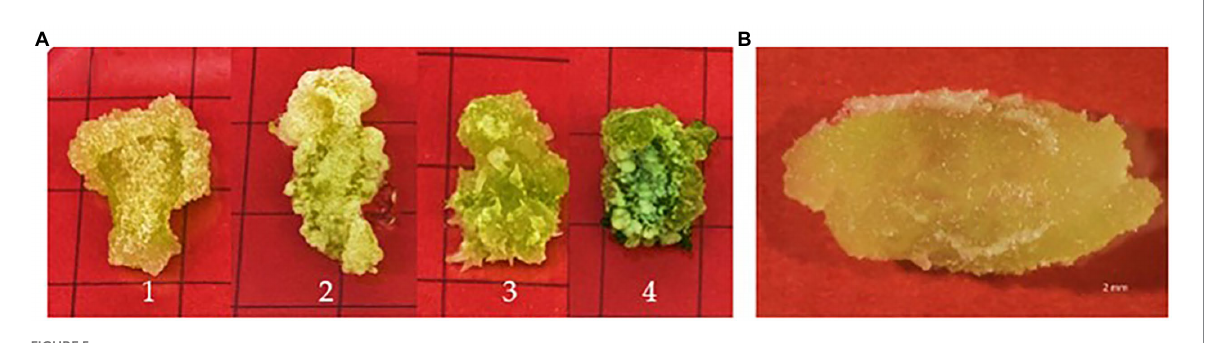
FIGURE 5 (A) Different textured H. tuberculatum callus in response to different combinations of PGRs (Plant Growth Regulators): (1) Friable callus, (2) Compact callus, (3) Rooty callus, (4) Compacted green callus, (B) Callus induction from leaf explant as whole plant development into a proliferating cell mass. Each treatment was replicated 10 times.